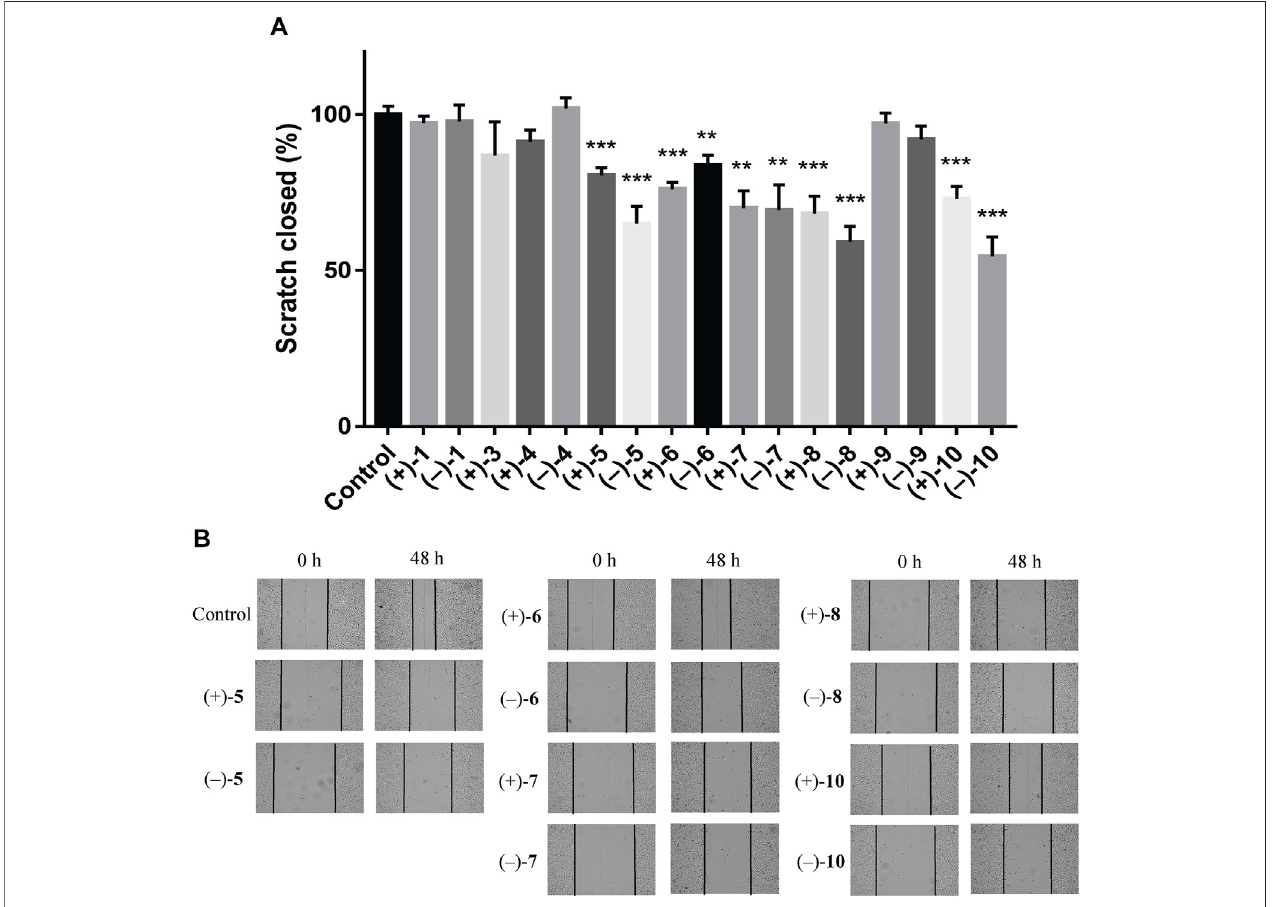
FIGURE 7 | Compounds suppress the migratory ability of MDA-MB-231 cells by wound healing assay. (A) Quanti fi cation of the migratory ability of compounds againstMDA-MB-231cellsat20 μ M.Theresultswererepresentedasmean±SDoftriplicates.** p < 0.01,*** p < 0.001(vs.controlgroup). (B) Representativeimagesof the wound healing assay in MDA-MB-231